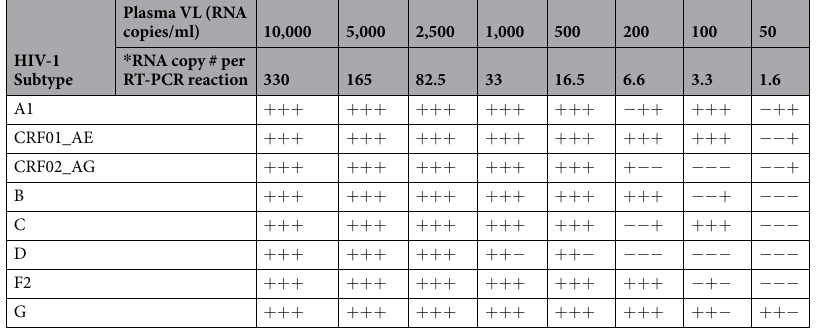
Table 1. Successful ( + ) or unsuccessful ( − ) PCR amplifications of 8 major HIV-1 subtypes in